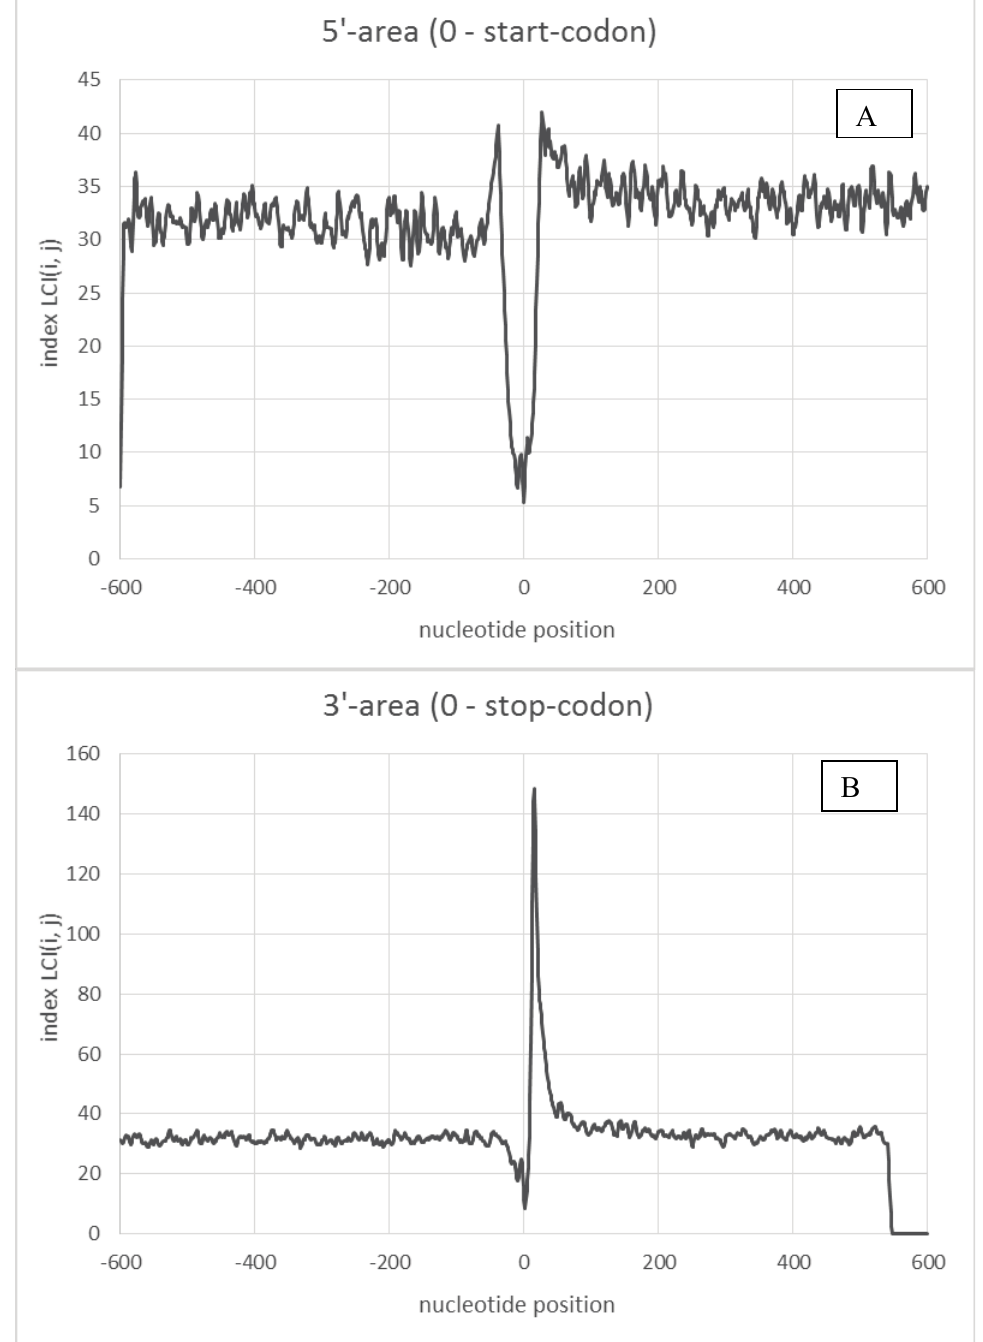
Figure. 2. Visualization of the average value of the LCI of individual nucleotides for all E. coli K-12 MG1655 genes. (A) 0 on the X-axis is the start codon of translation. (B) 0 on the X-axis is the stop codon of